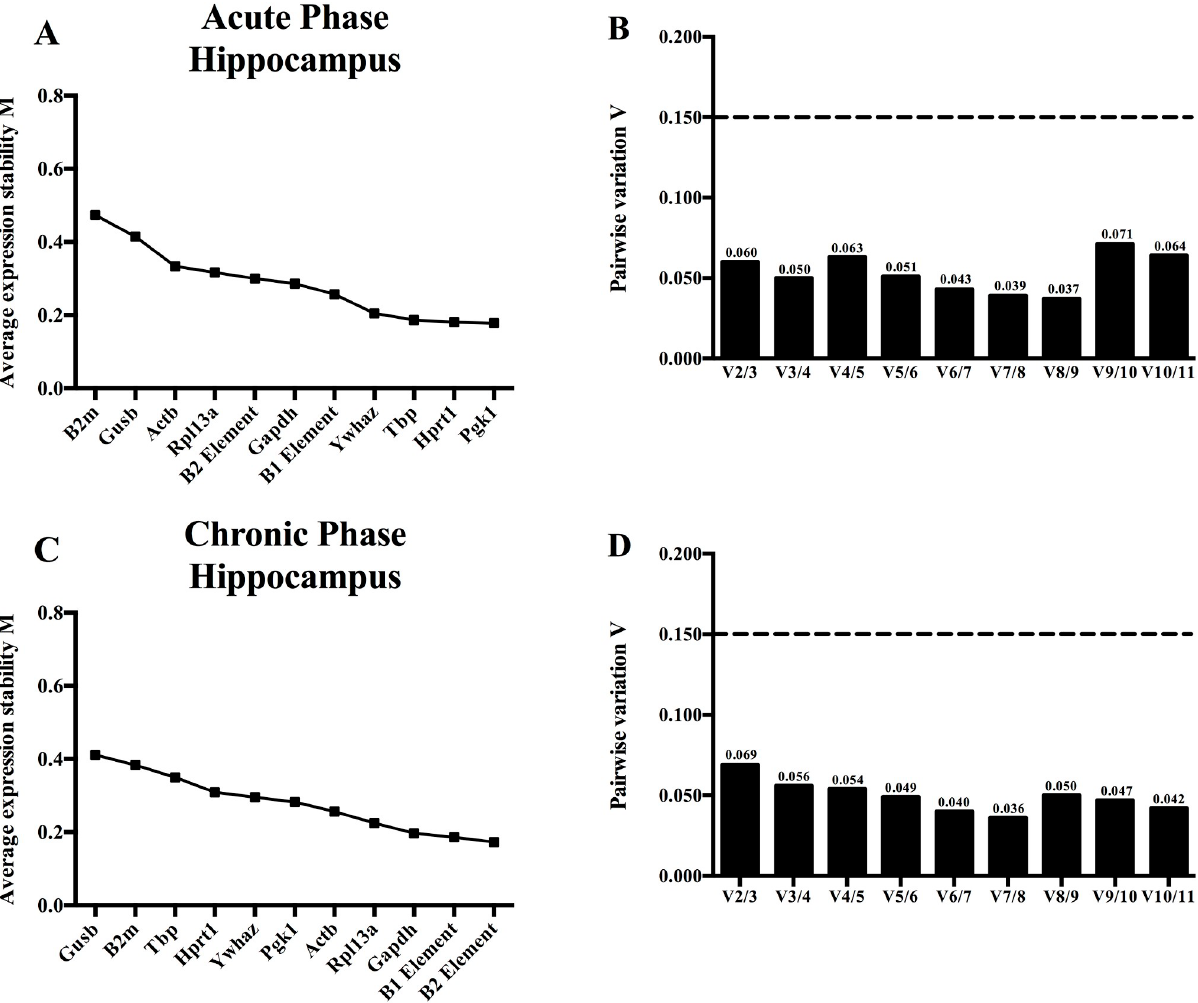
Fig 2. A geNorm analysis of the acute and chronic phase in the hippocampus of the TLE model. (A) Expression stability values (M values) of all the reference genes and B elements in the hippocampus of the acute phase. The higher the M value, the less stable the gene is expressed and vice versa. (B) Pair-wise variation analysis to determine the number of optimal genes for normalization in the acute phase. The software calculates a V value, which is an expressed variation number between the two calculated sequential normalization factors. (C) The M values of all the reference genes and B elements in the hippocampus of the chronic phase. (D) Pair-wise variation analysis to determine the number of optimal genes for normalization in the chronic phase.